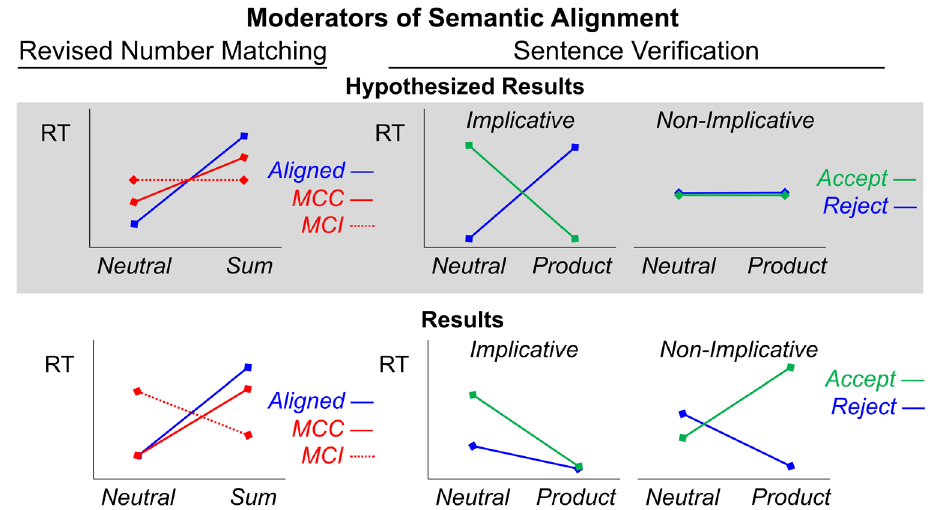
Figure 7. Priming effects for rejection trials on our revised Number Matching task and on acceptance and rejection trials on our Sentence Verification task. These effects contrast with our originally hypothesized results reported in Figure 1c, repeated here for